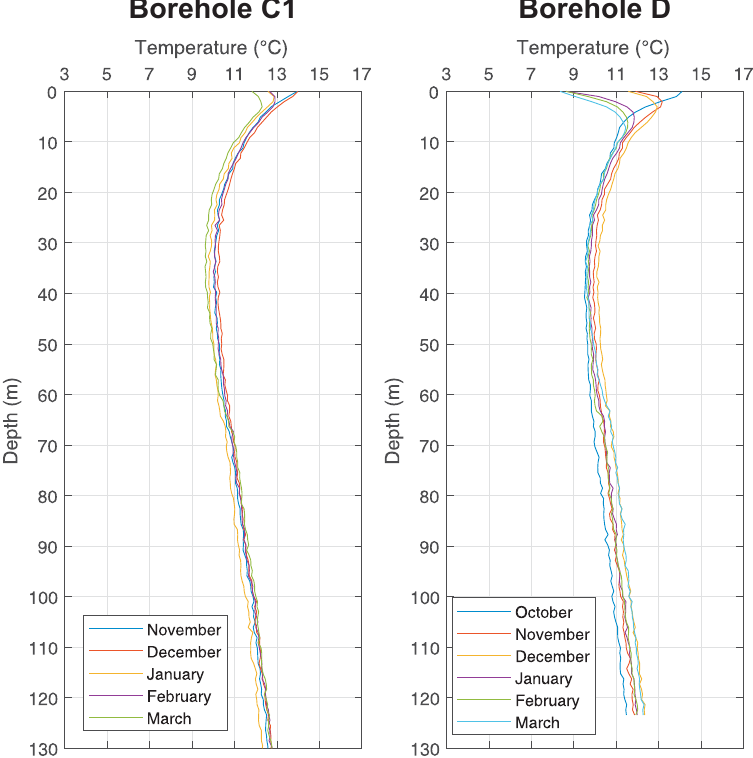
Figure 6. Graph of temperature changes with the depth at chosen monitoring borehole C1 and D of the Small Research Polygon